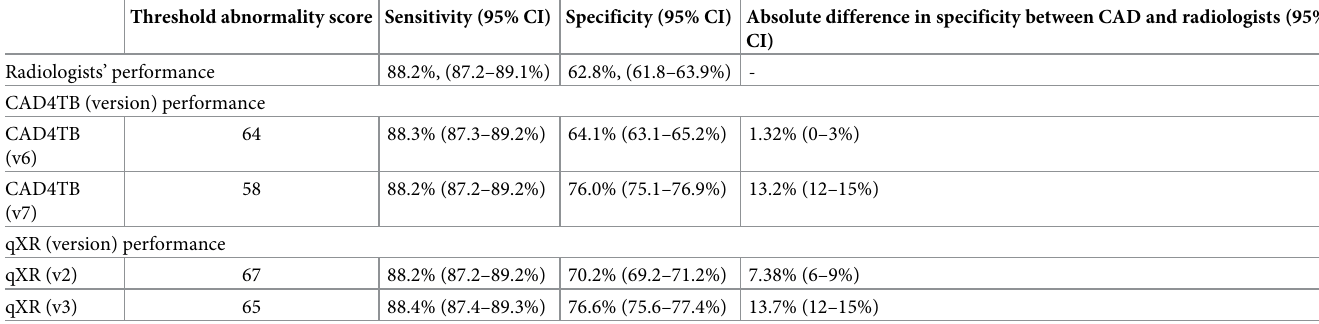
Table 2. Comparison of product versions against human radiologists.